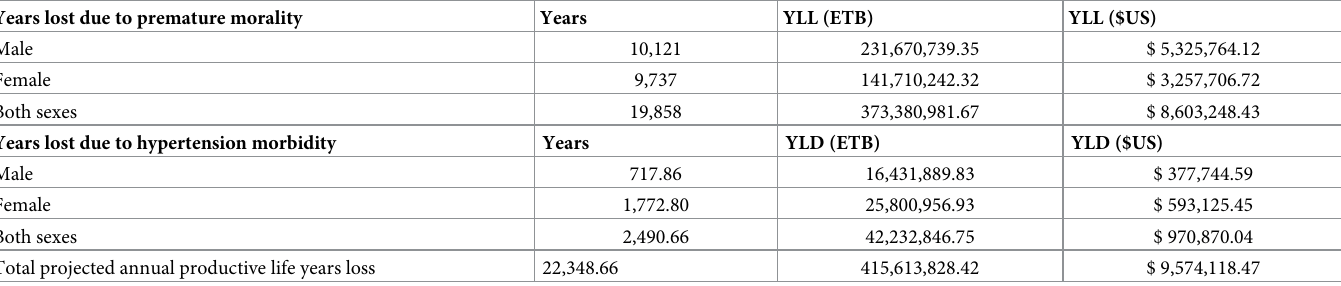
Table 3. Projected annual productive loss due to premature mortality (YLL) due to hypertension and hypertension-related morbidity (YLD) in Southern Ethiopia. Years lost due to premature morality